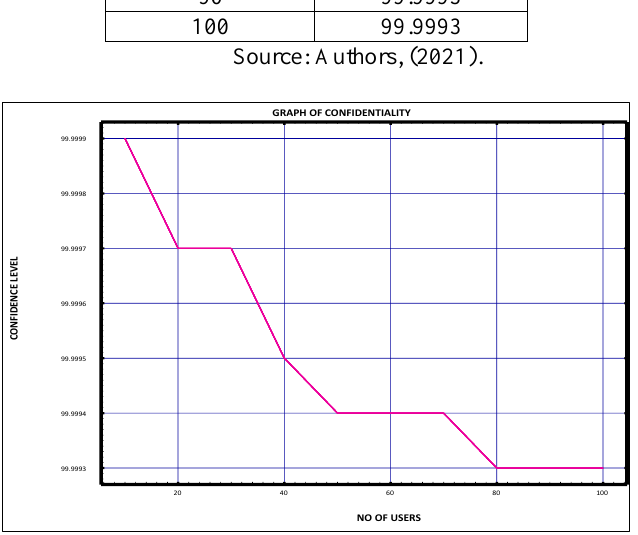
Figure 7: Confidentiality